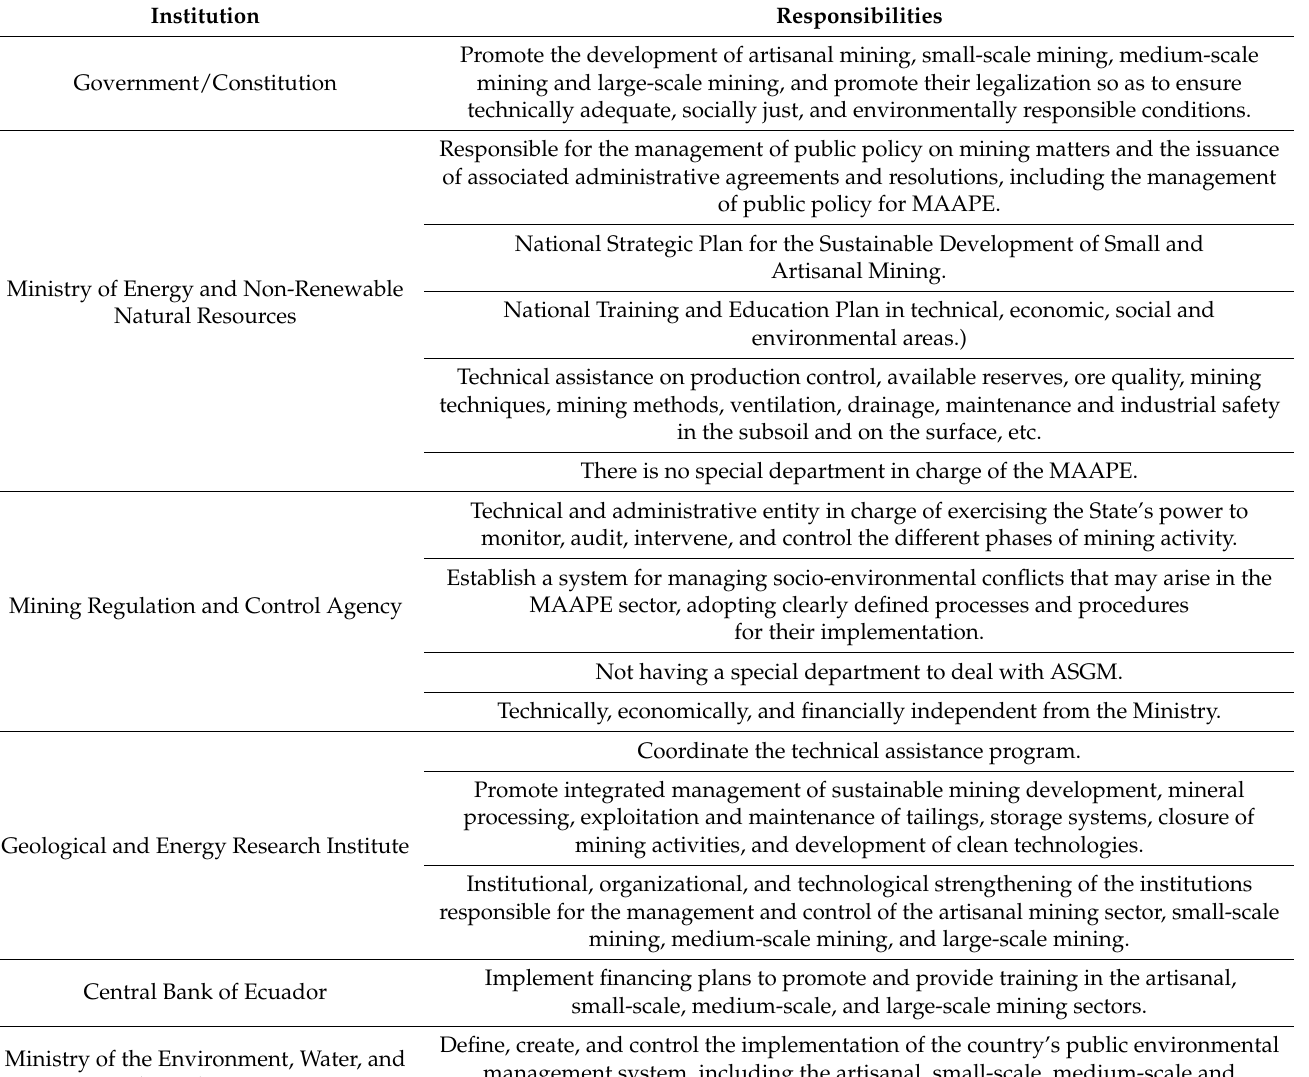
Table 5. Responsibilities of regulatory institutions in Ecuador.